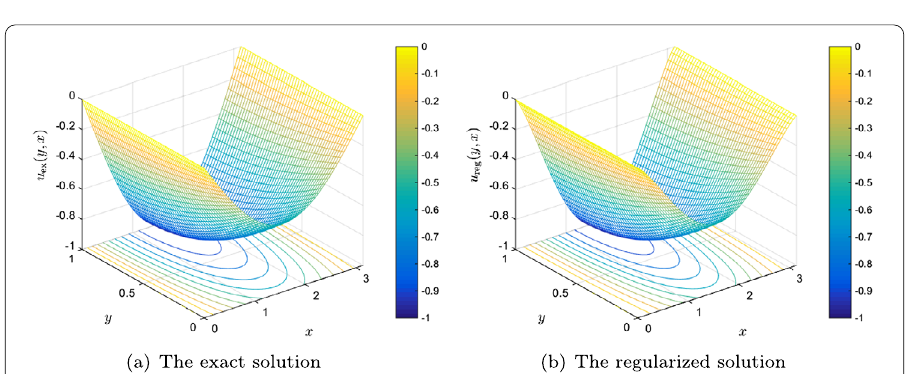
Figure 2 3D graphs of the exact and regularized